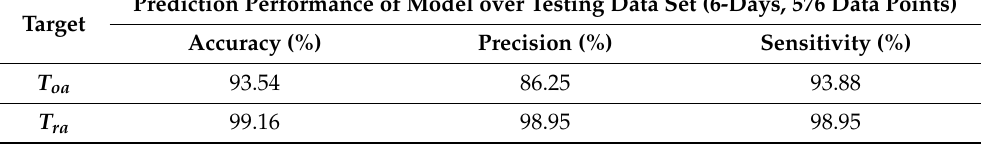
Table 10. Performance of MDFDD models: accuracy, precision and sensitivity.